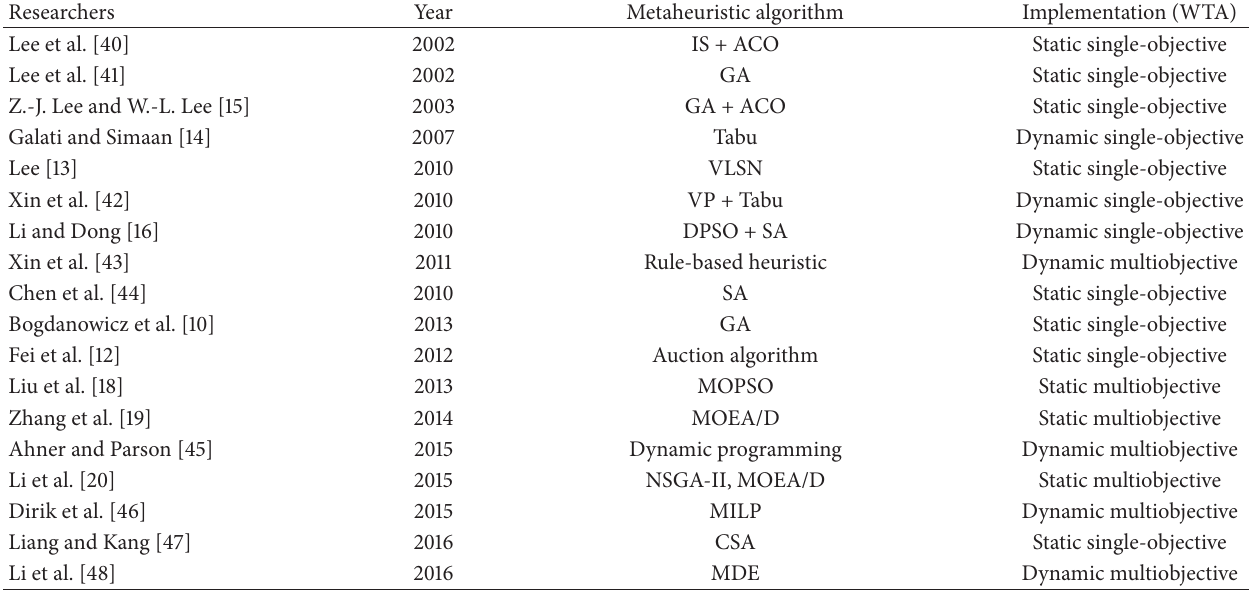
Table 1: Summary of variant metaheuristic algorithms and implementation of various